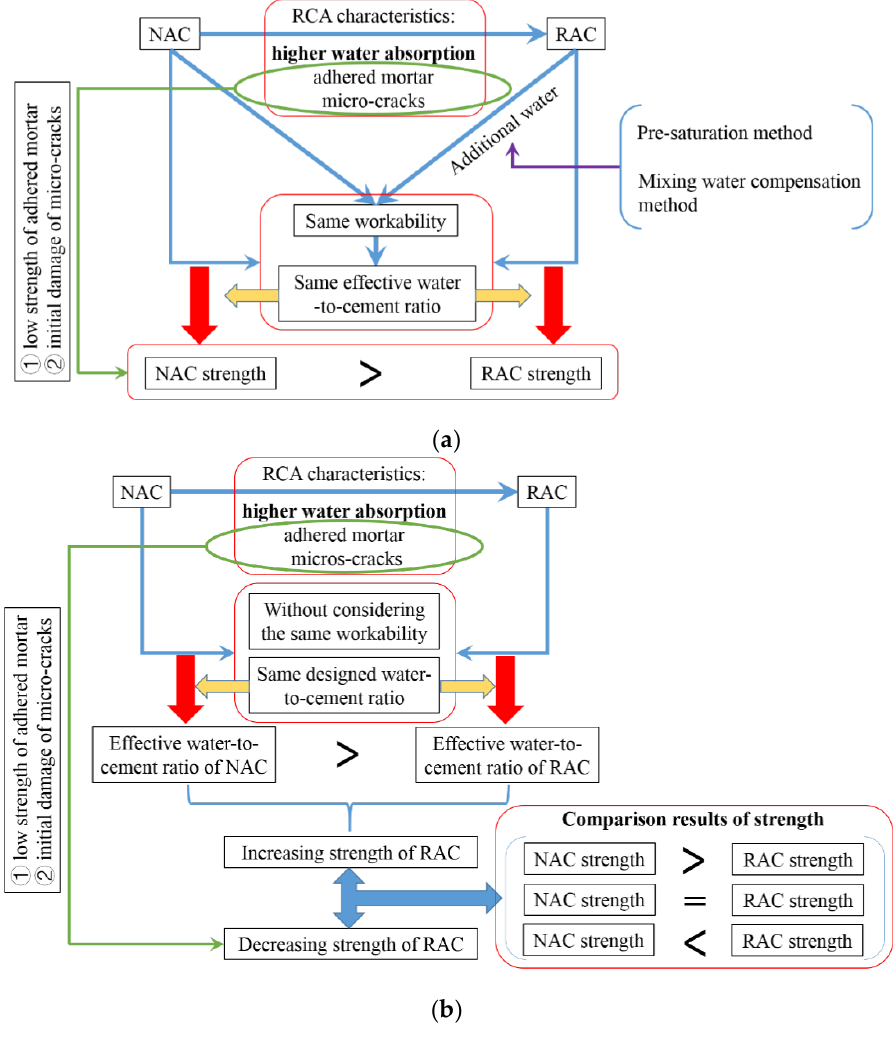
Figure 6. The relationship between recycled concrete aggregate (RCA) characteristics and concrete compressive strength using: ( a ) the additional water method, and ( b ) the equivalent total water method.